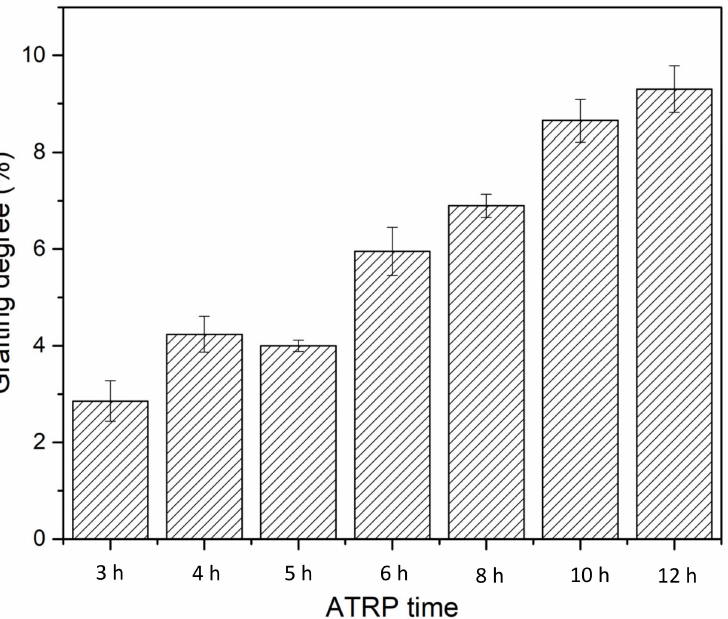
Figure 6. Grafting degree as a function of polymerization time for PVCL immobilized on the electrospun RC membrane substrate.